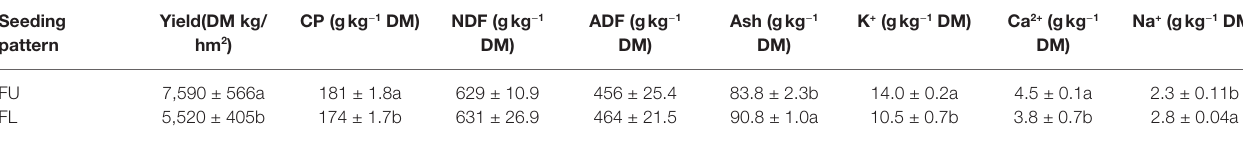
TABLE 3 | Alfalfa characteristics under two seeding pattern treatments at the first cut in 2020. Seeding pattern